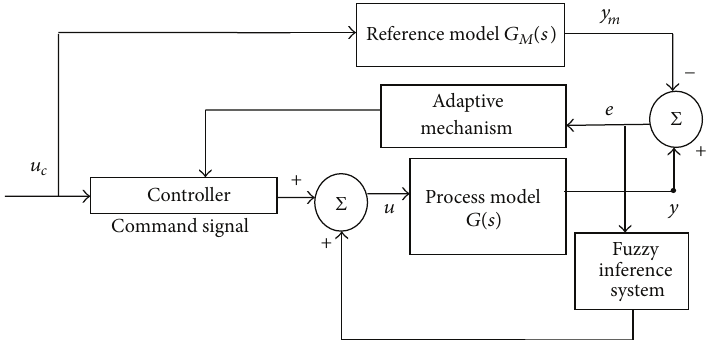
Figure 1: Fuzzy modified model reference adaptive